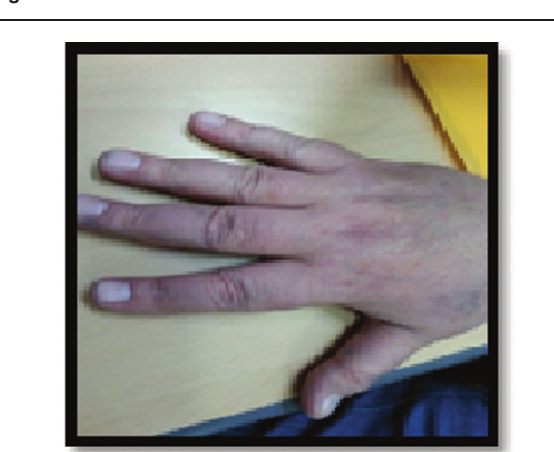
Boggy swelling in proximal interphalangeal and metacarpophalan- geal joints.